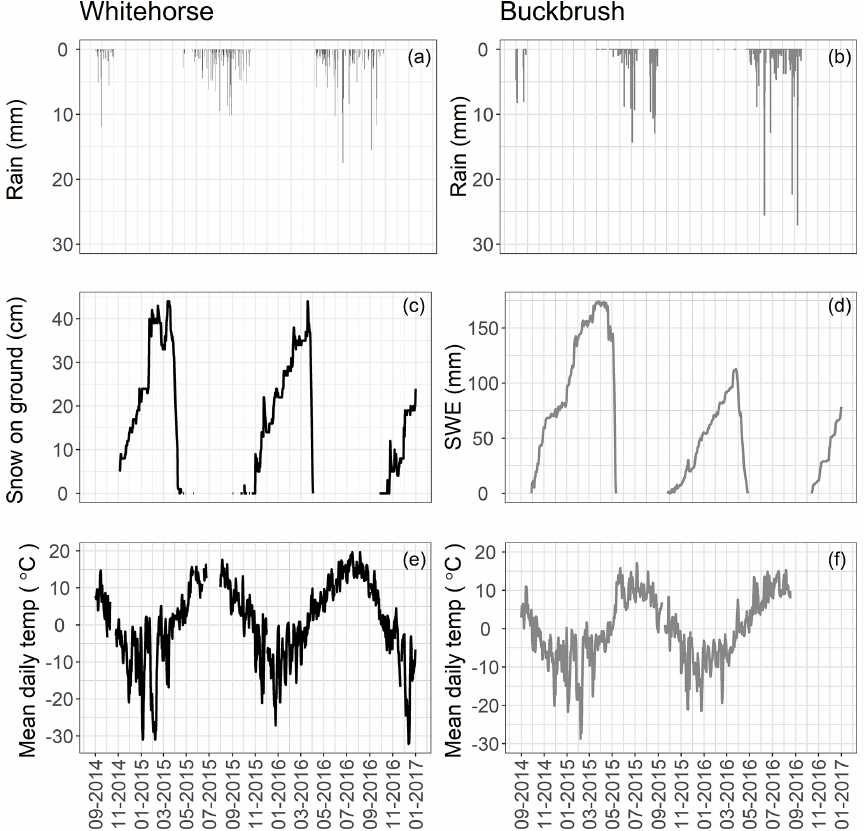
Figure 2. Climate variables from Whitehorse Auto (rainfall; 60 ◦ 43 (cid:48) 59.000 (cid:48)(cid:48) N, 135 ◦ 05 (cid:48) 52.000 (cid:48)(cid:48) W, 707ma.s.l.), Whitehorse Airport (snow on ground and mean daily temp; 60 ◦ 42 (cid:48) 34.200 (cid:48)(cid:48) N, 135 ◦ 04 (cid:48) 07.800 (cid:48)(cid:48) W) and Buckbrush weather stations (a, c, e) . Rain is measured (in mm) from Whitehorse Auto (climate ID: 2101310) located 3km from Whitehorse Airport, whereas snow on ground (in cm) and mean daily air temperature ( ◦ C) are measured from the Environment Canada Airport weather station (YXY, climate ID: 2101300) (MSC, 2017) located ∼ 14km northwest of Forest station at 706ma.s.l. (b, d, f) . Rainfall daily totals (inmm) were derived from hourly measurements, and snow water equivalent values (SWE; in mm) were based on 3h measurements from a snow pillow beside Buckbrush weather station. Daily average air temperature ( ◦ C) was derived from 30min